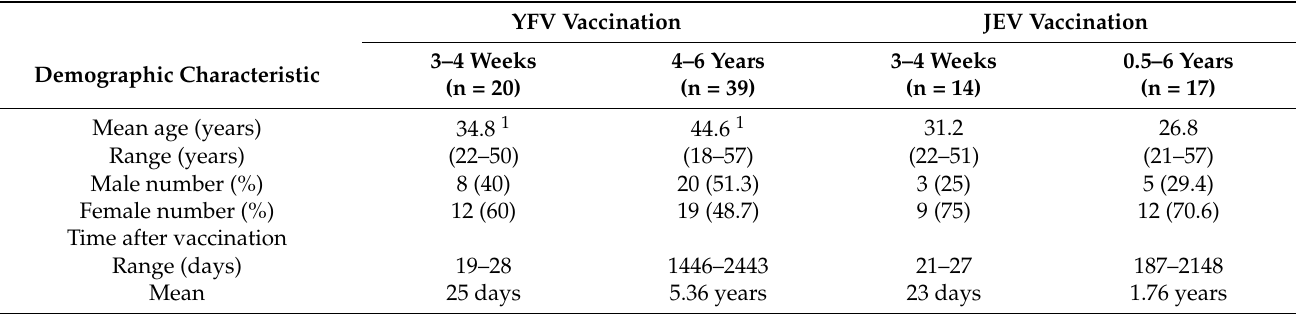
Table 1. Sociodemographic characteristics of the